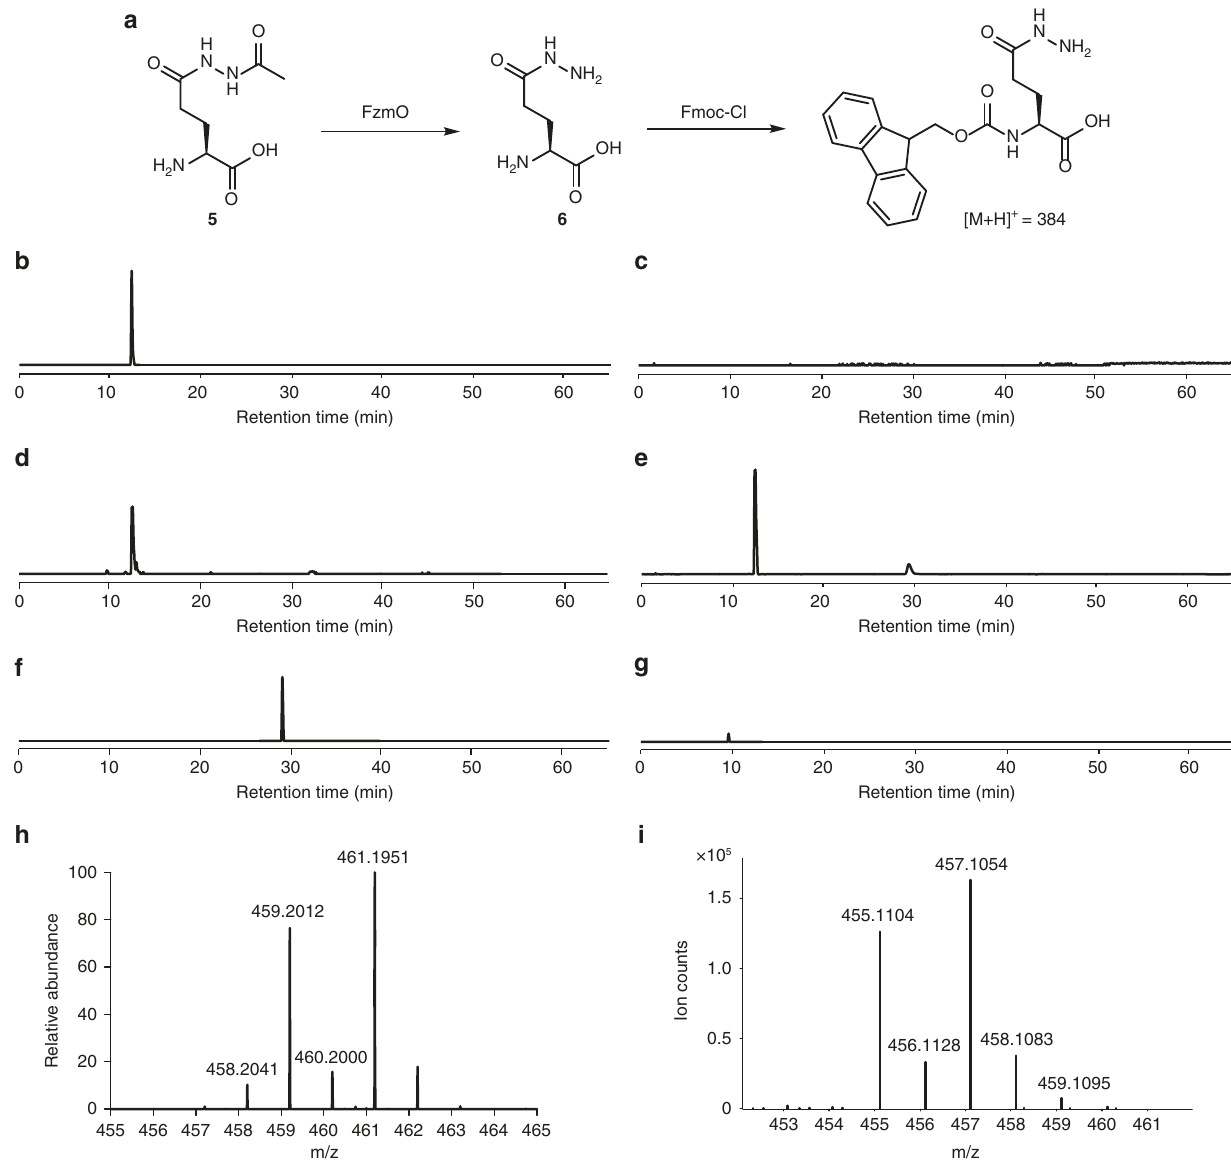
Fig. 5 FzmO converts glutamylacetylhydrazine ( 5 ) to glutamylhydrazine ( 6 ). All samples were derivatized with Fmoc-Cl, and the mass of Fmoc-derivatized 6 ([M + H] + = 384) was monitored by LC-MS. a Deacetylation of 5 to 6 by FzmO in vitro. b Extracted ion chromatogram (EIC) for m/z 384 of the reaction containing FzmO and 5 . c EIC for m/z = 384 of a sample containing 5 without FzmO. d EIC for m/z 384 of a synthetic standard of Fmoc- 6 . e EIC for m/z 384 of a synthetic standard of Fmoc- 6 spiked into the reaction mixture containing FzmO and 5 in panel b . f EIC for m/z 368 of Fmoc-derivatized Glu standard. g EIC for m/z 368 of the reaction mixture of FzmO and glutamylacetylhydrazine. h HRMS analysis of 14 N incorporation into 15 N-labeled fosfazinomycin A in Streptomyces sp. NRRL S-149 fed with unlabeled 6 . The calculated m/z ([M + H] + ) for 15 N-fosfazinomycin A containing two 14 N atoms is 459.2025. i HRMS analysis of 15 N incorporation into kinamycin D from feeding 0.2 mM of 15 N 2 - 6 to cultures of S. murayamaensis . 15 N 2 -kinamycin D ([M + H] + =